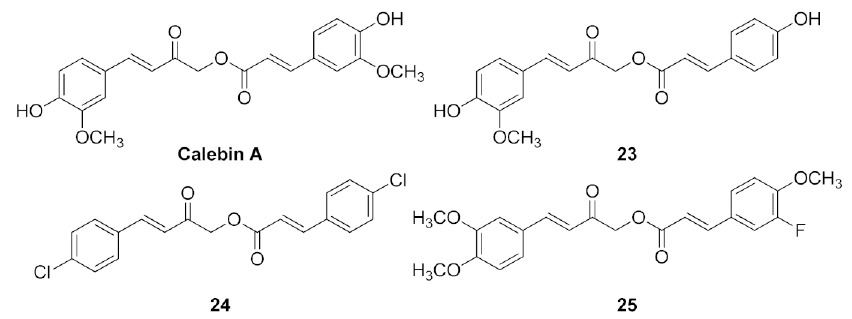
Figure 10. Structures of Calebin A and its